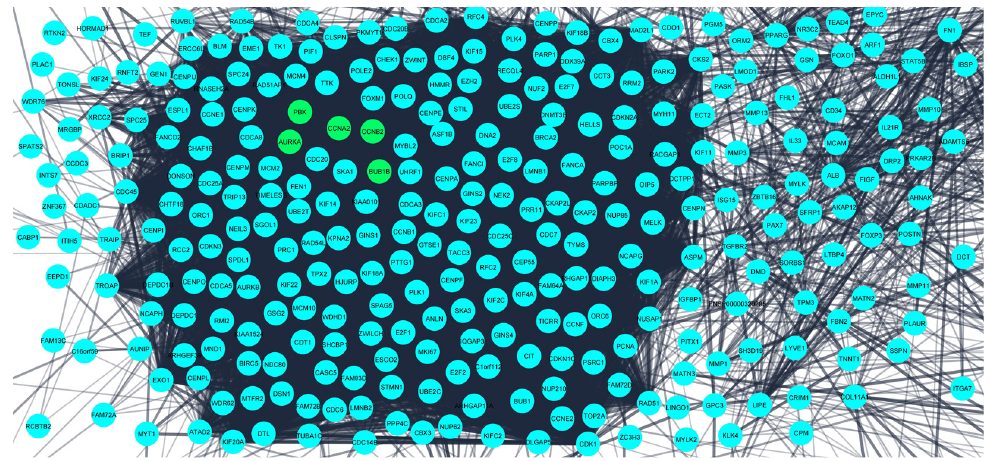
Figure 3. Protein–protein interaction network for the 824 differentially expressed genes obtained from STRING database. The confidence interval was > 0.7. Nodes represent interacting proteins and the edges represent the interaction between these proteins. The 5 hub genes (potential prognostic biomarkers) are shown in green color.